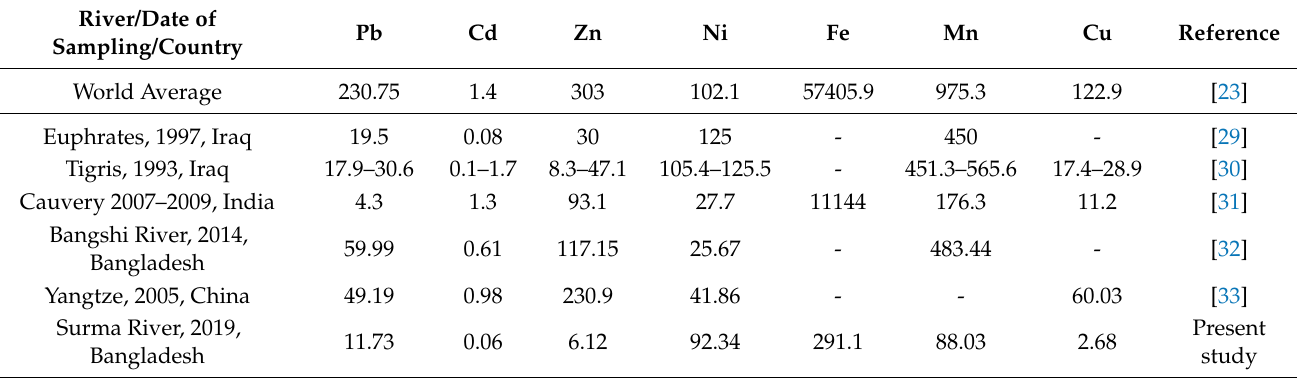
Table 2. Comparison of metals in sediment with other studies around the globe (units in